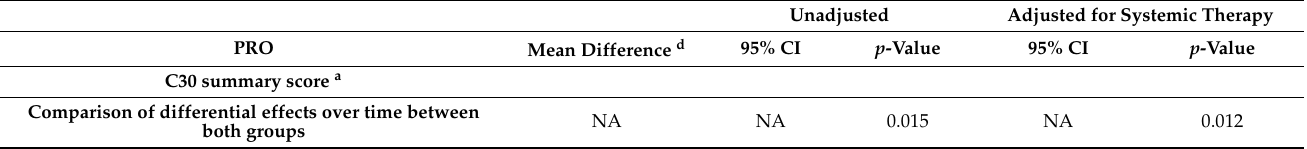
Table 2. Linear mixed modeling on comparisons between both groups, with and without correction for systemic